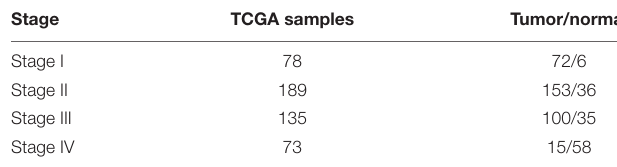
TABLE 5 | Gene expression profiles in different stages for The Cancer Genome Atlas colon and rectal cancer gene expression profile (the detailed clinical information of colon adenocarcinoma is in Supplementary Table S1 ).